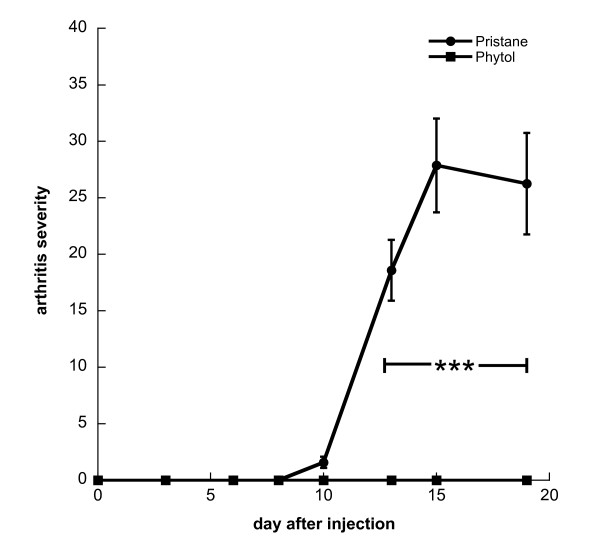
Arthritis development in rats after subcutaneous administration of pristane (circles) or phytol (squares) in the time study experiment. Only animals injected with pristane developed arthritis. Values are means ± SEM from groups of four animals. Levels of significance were calculated using Student's t-test (***p < 0.001).